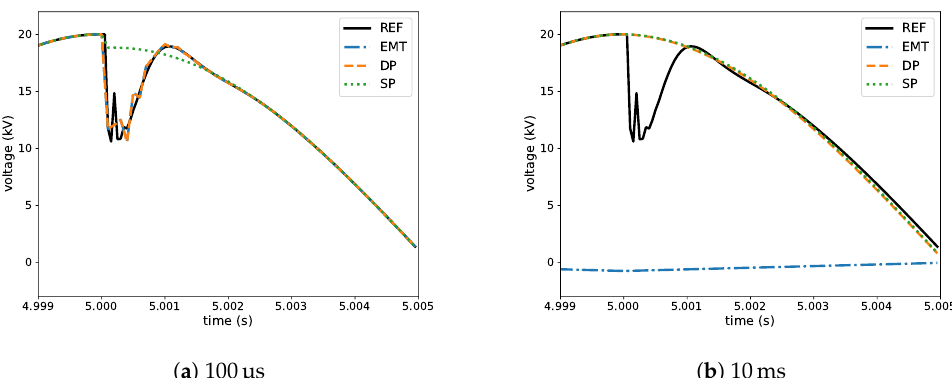
Figure 2. Terminal voltage transient of voltage source inverter with an open control loop simulated in the electromagnetic transient (EMT), dynamic phasor (DP) and static phasor (SP) domain in comparison to the reference simulation (REF) considering characteristic simulation step sizes of ( a ) 100µs and ( b )